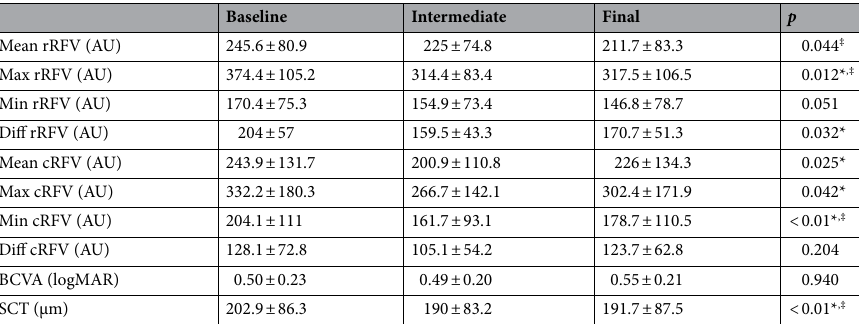
Table 2. Average values of study parameters. Data are shown as mean ± standard deviation. rRFV retinal arterial relative flow volume, cRFV choroidal relative flow volume, BCVA best-corrected visual acuity, logMAR logarithm of the minimum angle of resolution, SCT subfoveal choroidal thickness. Data are presented as means ± SD. Changes over time were analyzed with repeated measures ANOVA. *Statistically significant difference between baseline and intermediate visit. ‡ Statistically significant difference between baseline and final